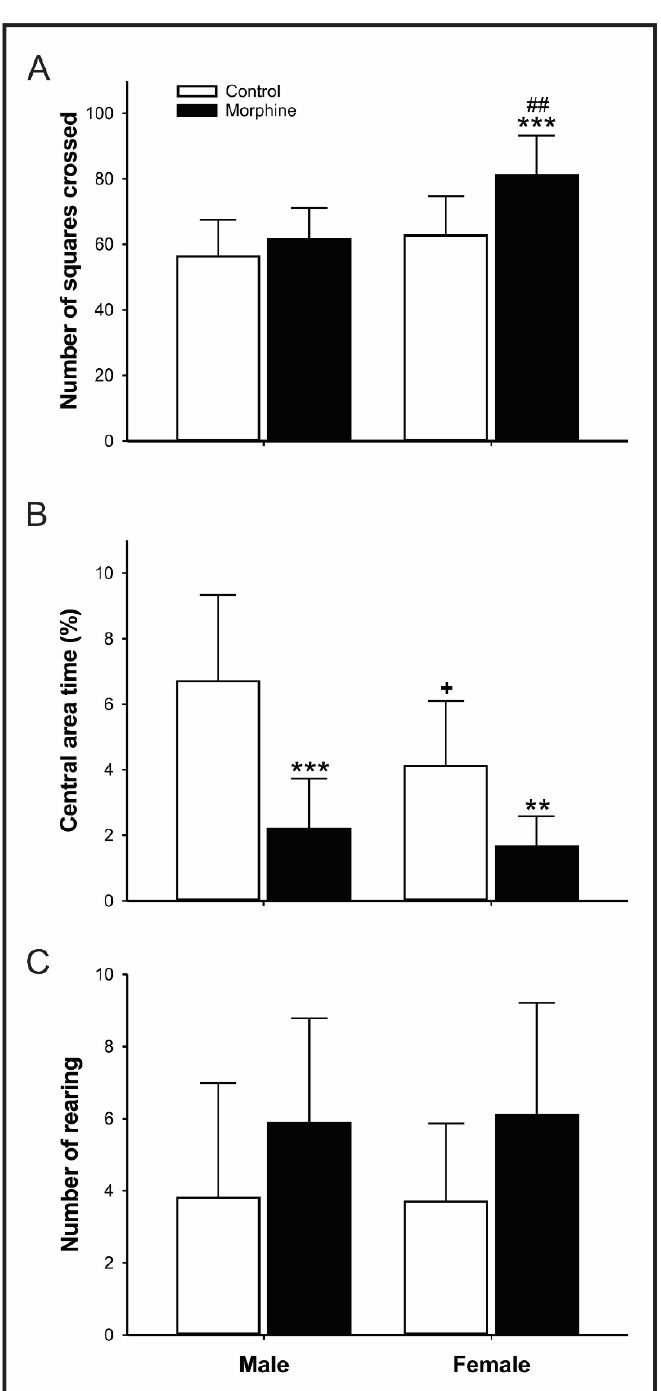
male control group (Male vs. Females: p = 0.016, U = 15.000). As illustrated in Figure 3C, the number of rearing was not affected by morphine intrauterine exposure.